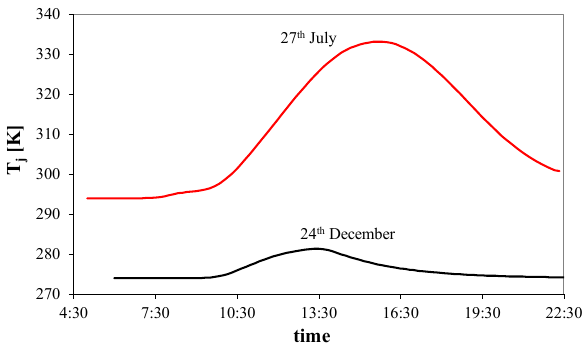
Figure 9. Computed waveforms of the internal temperature of the photovoltaic panels on selected days .